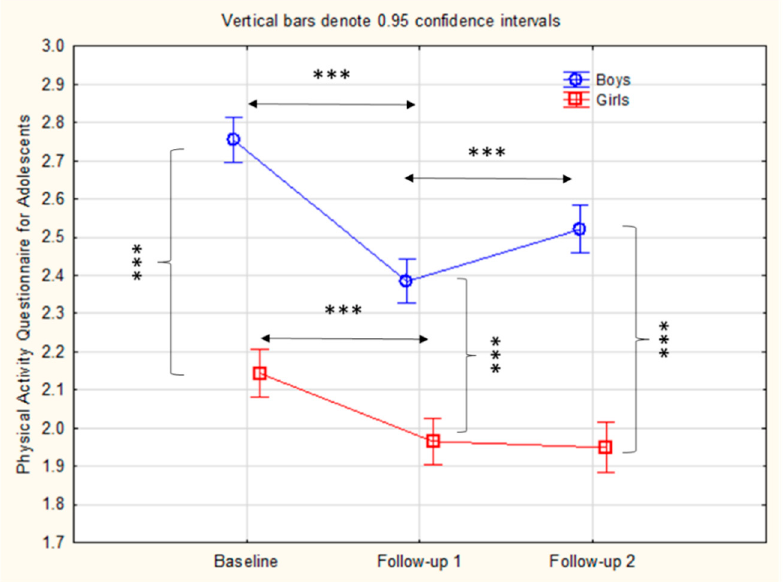
Figure 2. Descriptive statistics (Mean ± 95% CI) and statistical significance of the differences between and within groups/genders obtained by post-hoc Schefee test (*** indicates p-level of 0.001).